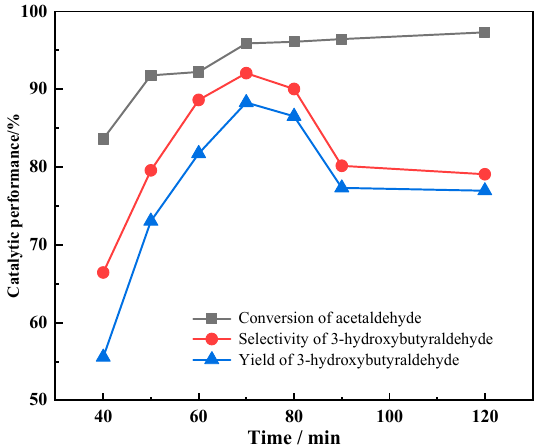
Figure 8. Effect of residence time on AcH condensation.